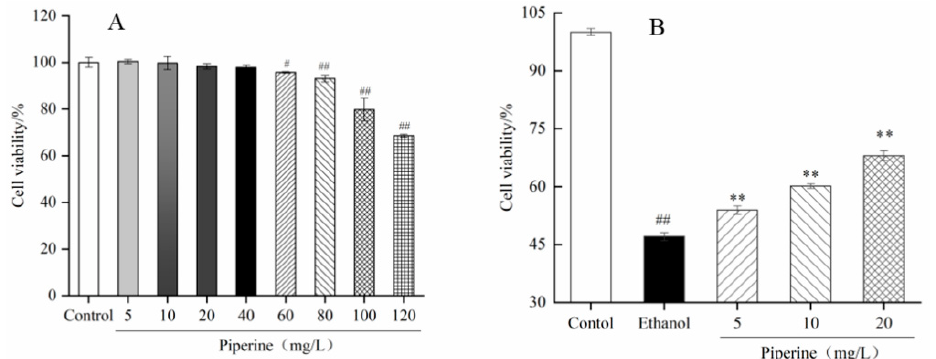
Figure 1. Effect of piperine on GES-1 cells. ( A ) Cell viability. ( B ) Protective activity of piperine against ethanol-induced GES-1 cells. Ave ± SD, # p < 0.05, ## p < 0.01 vs. control group; ** p < 0.01 vs. ethanol group.